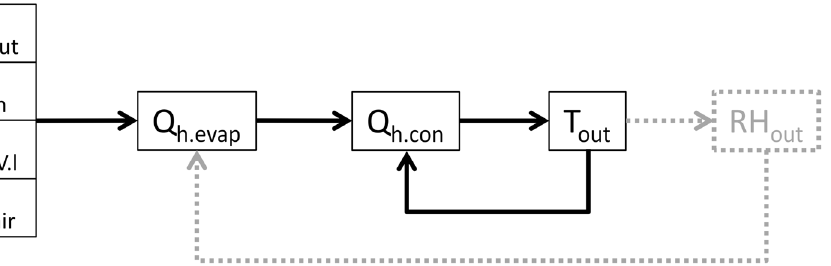
Figure 2. Overview of iteration steps in our spray dryer model. Details are left out for clarity. Model expansion for relative humidity at the spray dryer outlet ( RH out ) will be discussed in the results.